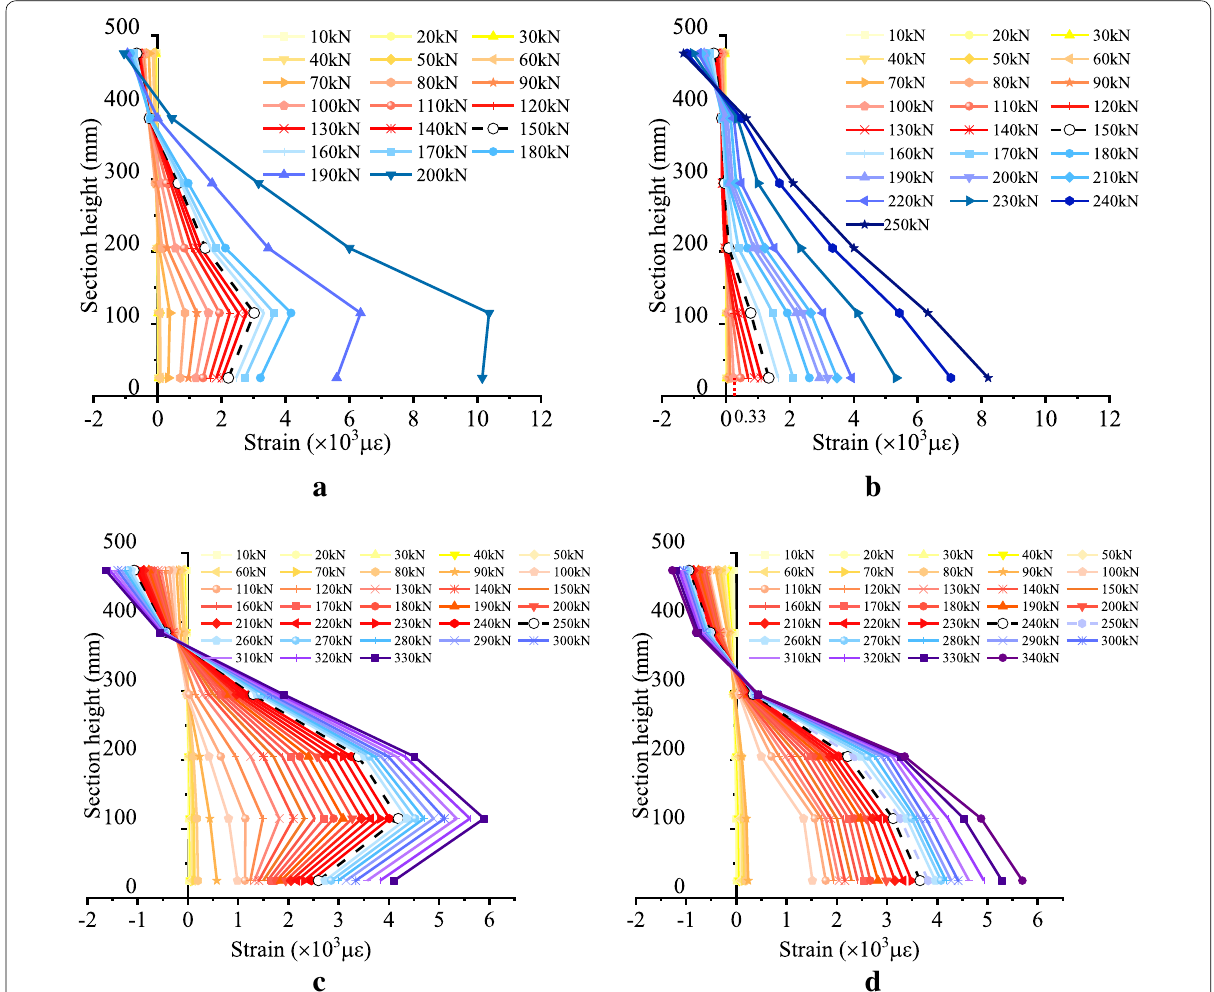
Fig. 17 Location-strain curves of RC beams’ mid-span cross-section with different reinforcement ratios: a location-strain curves of the contrast beam (B1); b location-strain curves of CFRP-strengthened beam B3; c location-strain curves of CFRP-strengthened beam B4; d location-strain curves of CFRP-strengthened beam